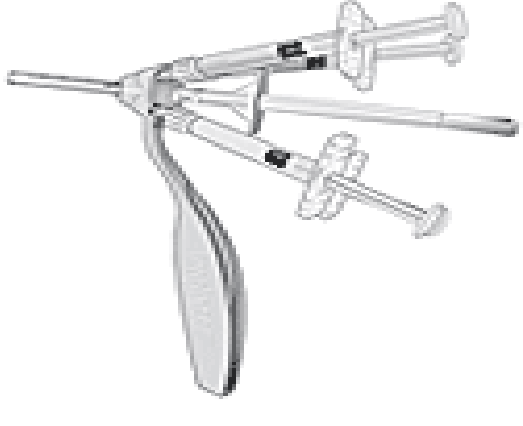
FIGURE 1. Implacer